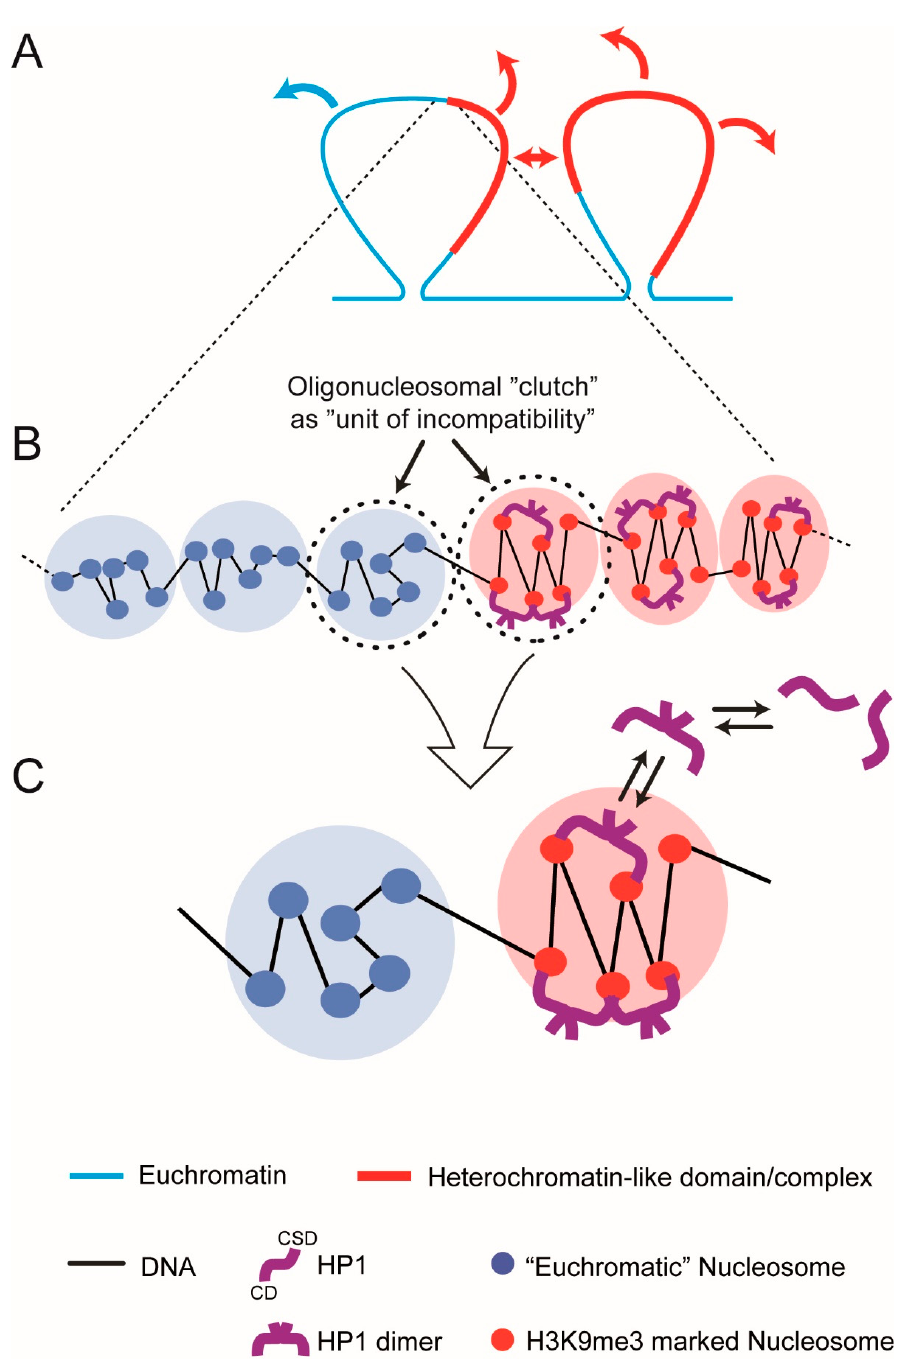
Figure 6. The oligo-nucleosomal “clutch” as the “unit of incompatibility” of chromatin. ( A ) Chromatin loops containing two heterochromatin -like domains/complexes (red line) flanked by euchromatin (blue line). Heterochromatin -like domains/complexes make cis- (doubled-headed arrow) and trans- (red arrows) contacts other micro-phase separated heterochromatin -like domains/complexes (Diagram B in Box S1). The cis- and trans- contacts between micro-phase separated heterochromatin- like domains/complexes generate contact enrichments seen in ECDs (Diagram C in Box S1). The euchromatic segments can also make cis- (not shown) and trans- (blue arrow) contacts with other euchromatic segments that are detected as A-type compartments in Hi-C maps. ( B ) A region of the loop in ( A